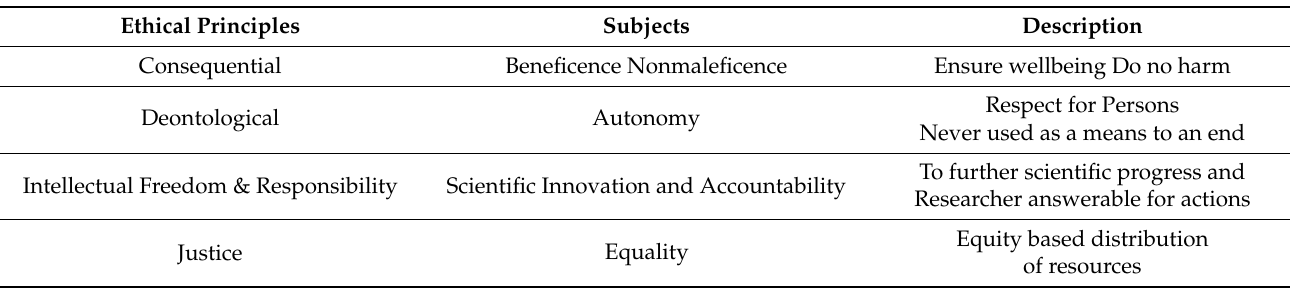
Table 2. Ethical